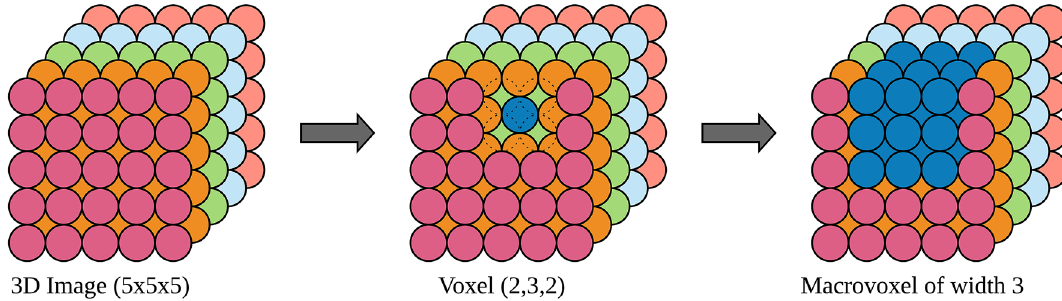
Figure 2. Macrovoxel of width 3 of the voxel (2,3,2) in a 3D-image of size 5